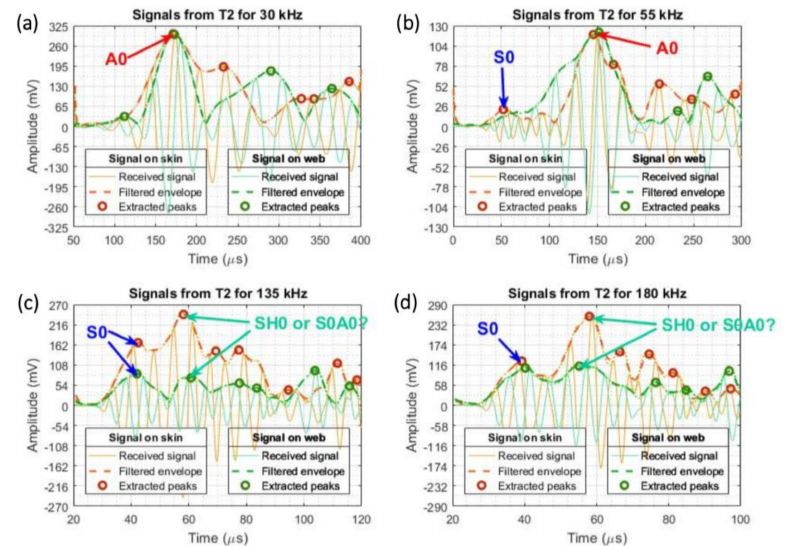
Figure 6. Identification of A 0 and S 0 modes for signals transmitted from ‘T2’ and received on skin by ‘R8’ and on web by ‘R5’ at frequencies: ( a ) 30 kHz; ( b ) 55 kHz; ( c ) 135 kHz; and ( d ) 180